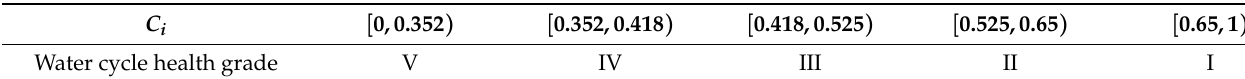
Table 3. Classification standard of water cycle health [19].